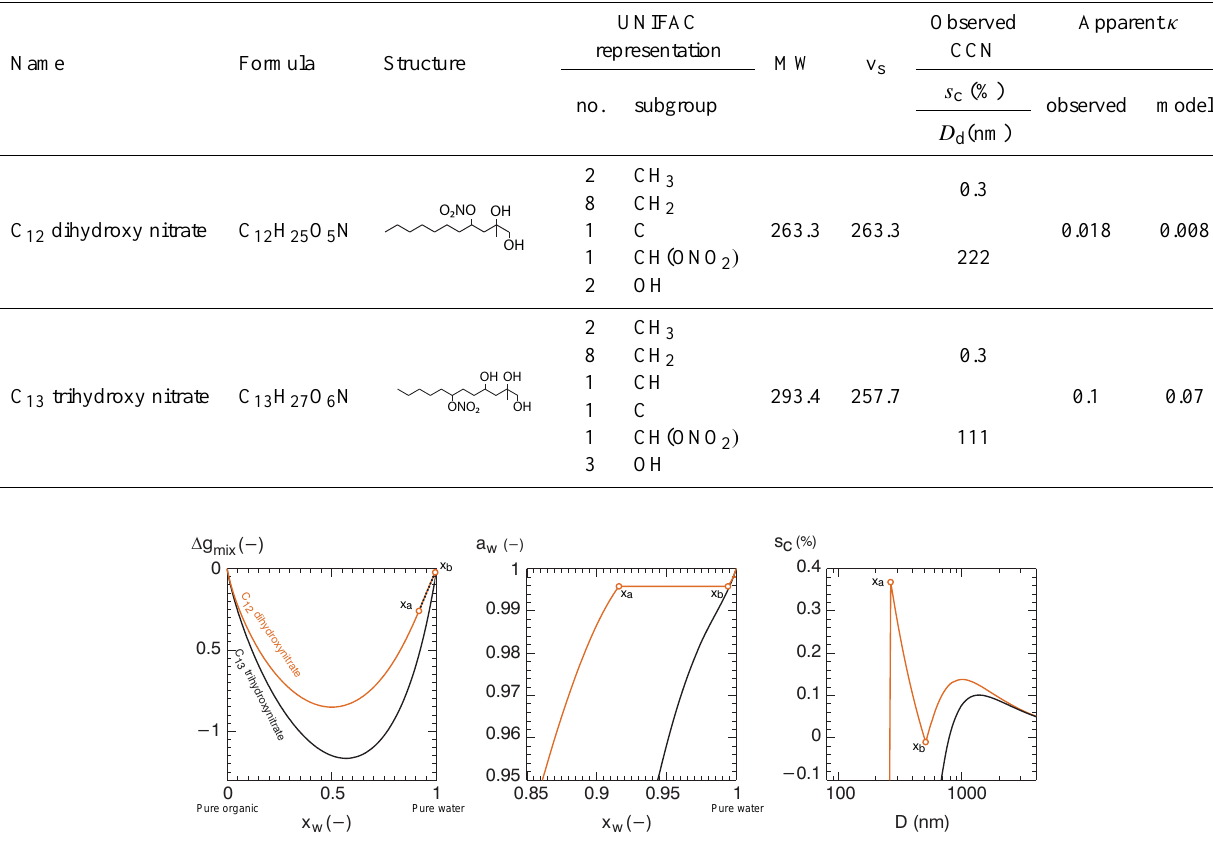
Table 1. Properties for two example chemical compounds. UNIFAC representation indicated the 633